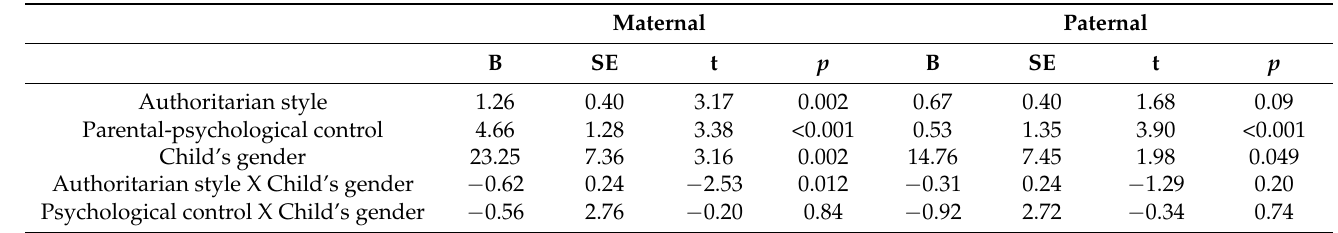
Table 3. Moderation and moderated mediation analysis for impostor feelings: Regression model predicting impostor feelings from authoritarian parenting and psychological control as a mediator with child’s gender as a moderator. Maternal